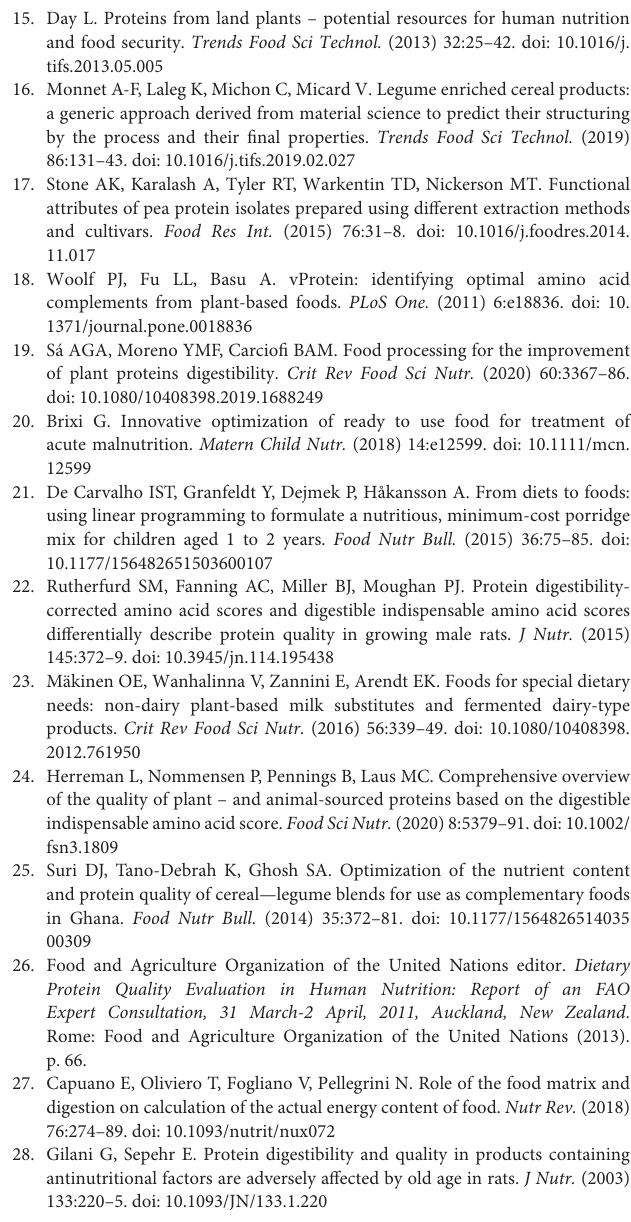
Supplementary Table 1 | Nutritional information of the protein sources and